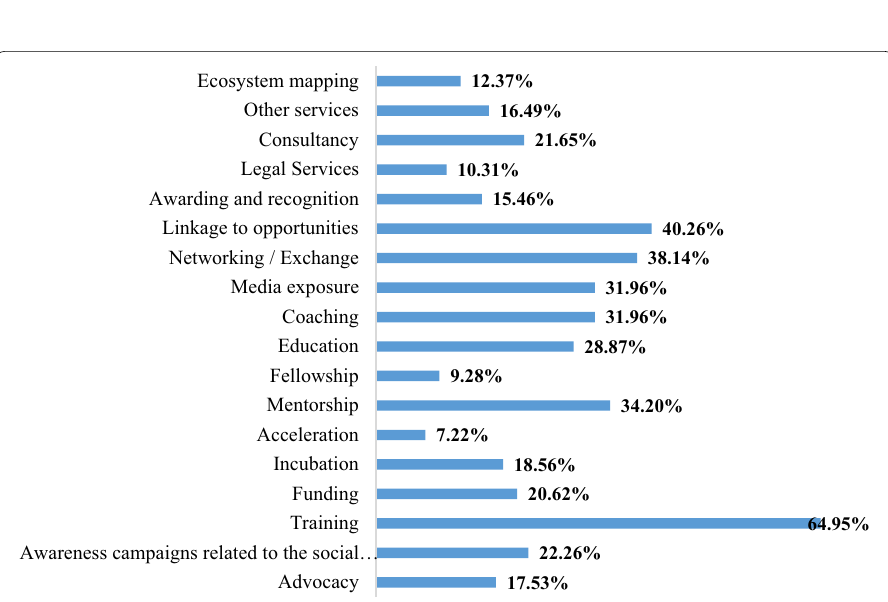
Fig. 13 Distributions of the services’ percentages provided by the organizations providing multiple